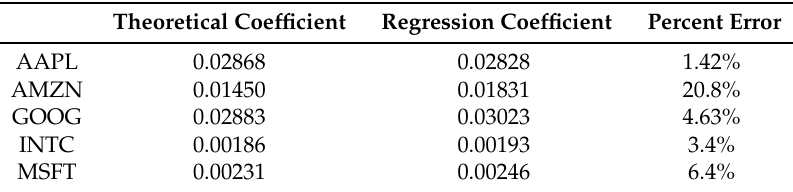
Table 9. The coefficients calculated for AAPL, AMZN and GOOG are generated using a Markov chain created by 16 quantiles on the upward and downward movements, while the coefficients for INTC and MSFT are obtained from the CHPDO